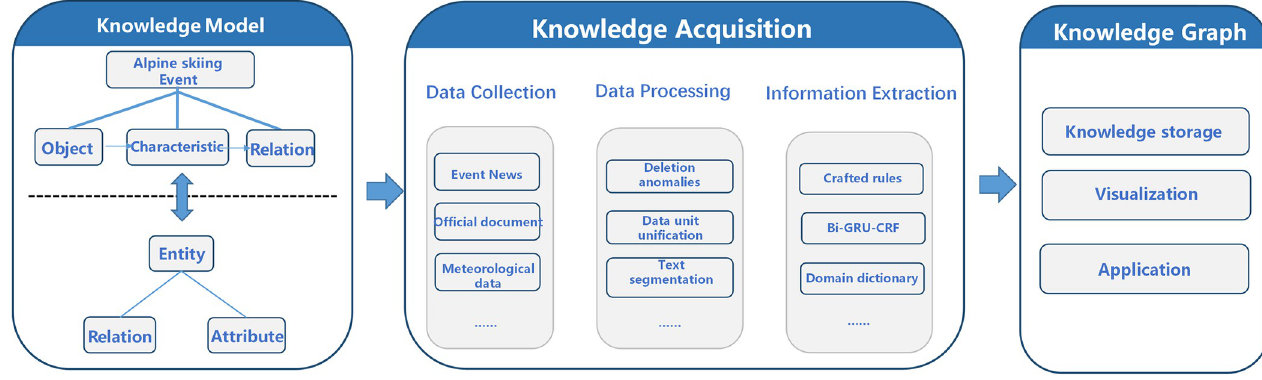
Fig 1. Flow chart for the construction of